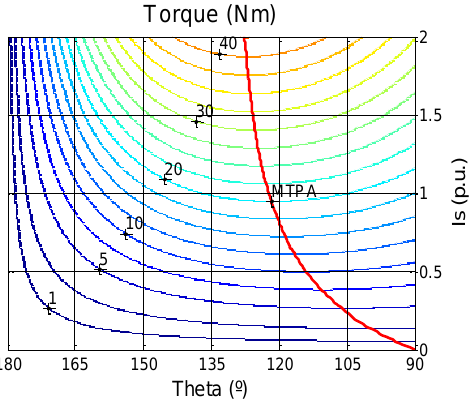
Figure 6. Interior PMSM torque as a function of stator current and MTPA trajectory (simulation